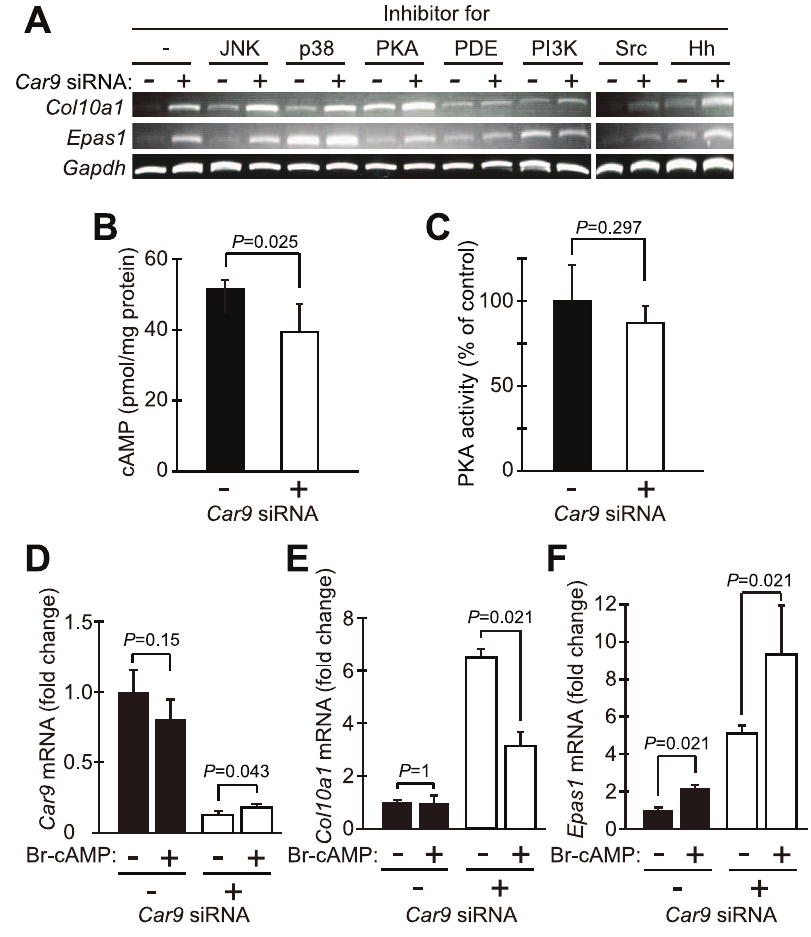
Figure 8. Intracellular signaling cascades involved in regulation of Col10a1 expressions by CA IX. Car9 siRNA or control siRNA was introduced into primary chondrocytes. A. At 24 hours after introduction of the siRNAs, the culture medium was changed to that containing the JNK inhibitor SP600125 (30 m M), p38 MAPK (p38) inhibitor SB202190 (20 m M), PKA inhibitor H89 (10 m M), PDE inhibitor IBMX (0.1 mM), PI3K inhibitor LY294002 (20 m M), Src kinase Inhibitor I (20 m M), or hedgehog (Hh) inhibitor Jervine (10 m M). After additional incubation for 24 hours, the mRNA expressions of Epas1 , Col10a1 , and Gapdh were examined by RT-PCR. B. At 36 hours after introduction of Car9 or control siRNA to primary chondrocytes, cAMP was extracted with 0.1 M HCl and its level was determined using an EIA Kit, then corrected for cellular protein. Data